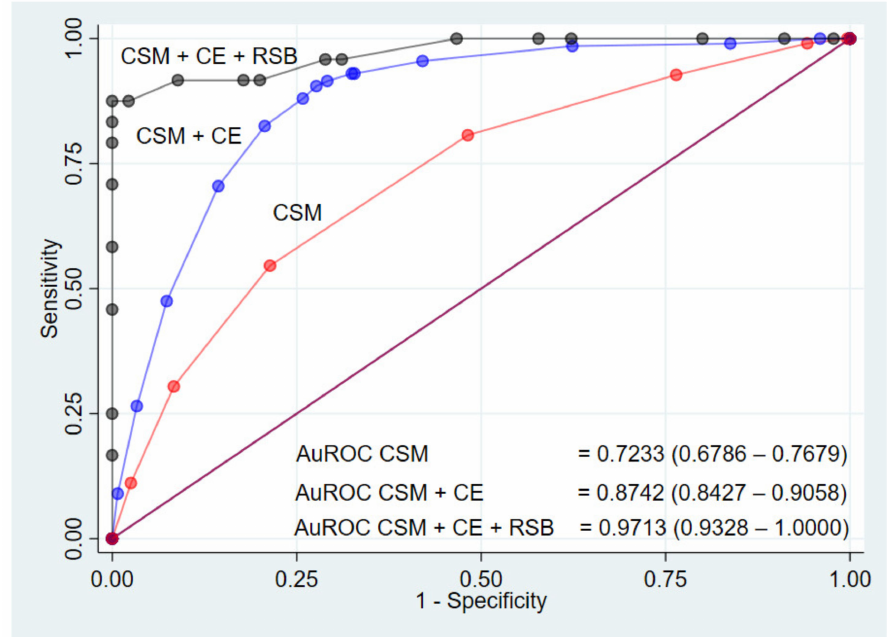
Figure 4. The receiver operating characteristic curve (ROC) for the prediction models for diagnosis of HSCR predicted by clinical score model (CSM), CSM + contrast enema (CE), and CSM + CE + rectal suction biopsy (RSB) (three-curved lines) and a 50% chance prediction (diagonal